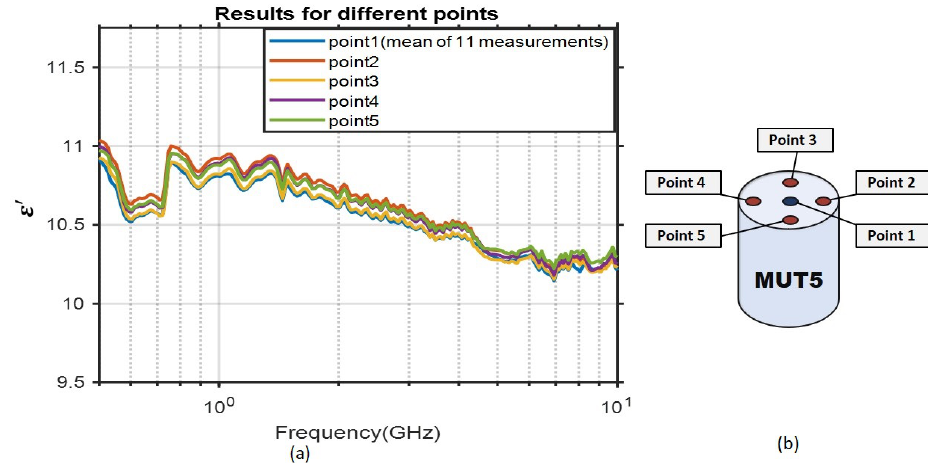
Figure 7. Homogeneity evaluation of MUT5. ( a ): The permittivity result of five different points. ( b ): The positions of the five different measurement points.